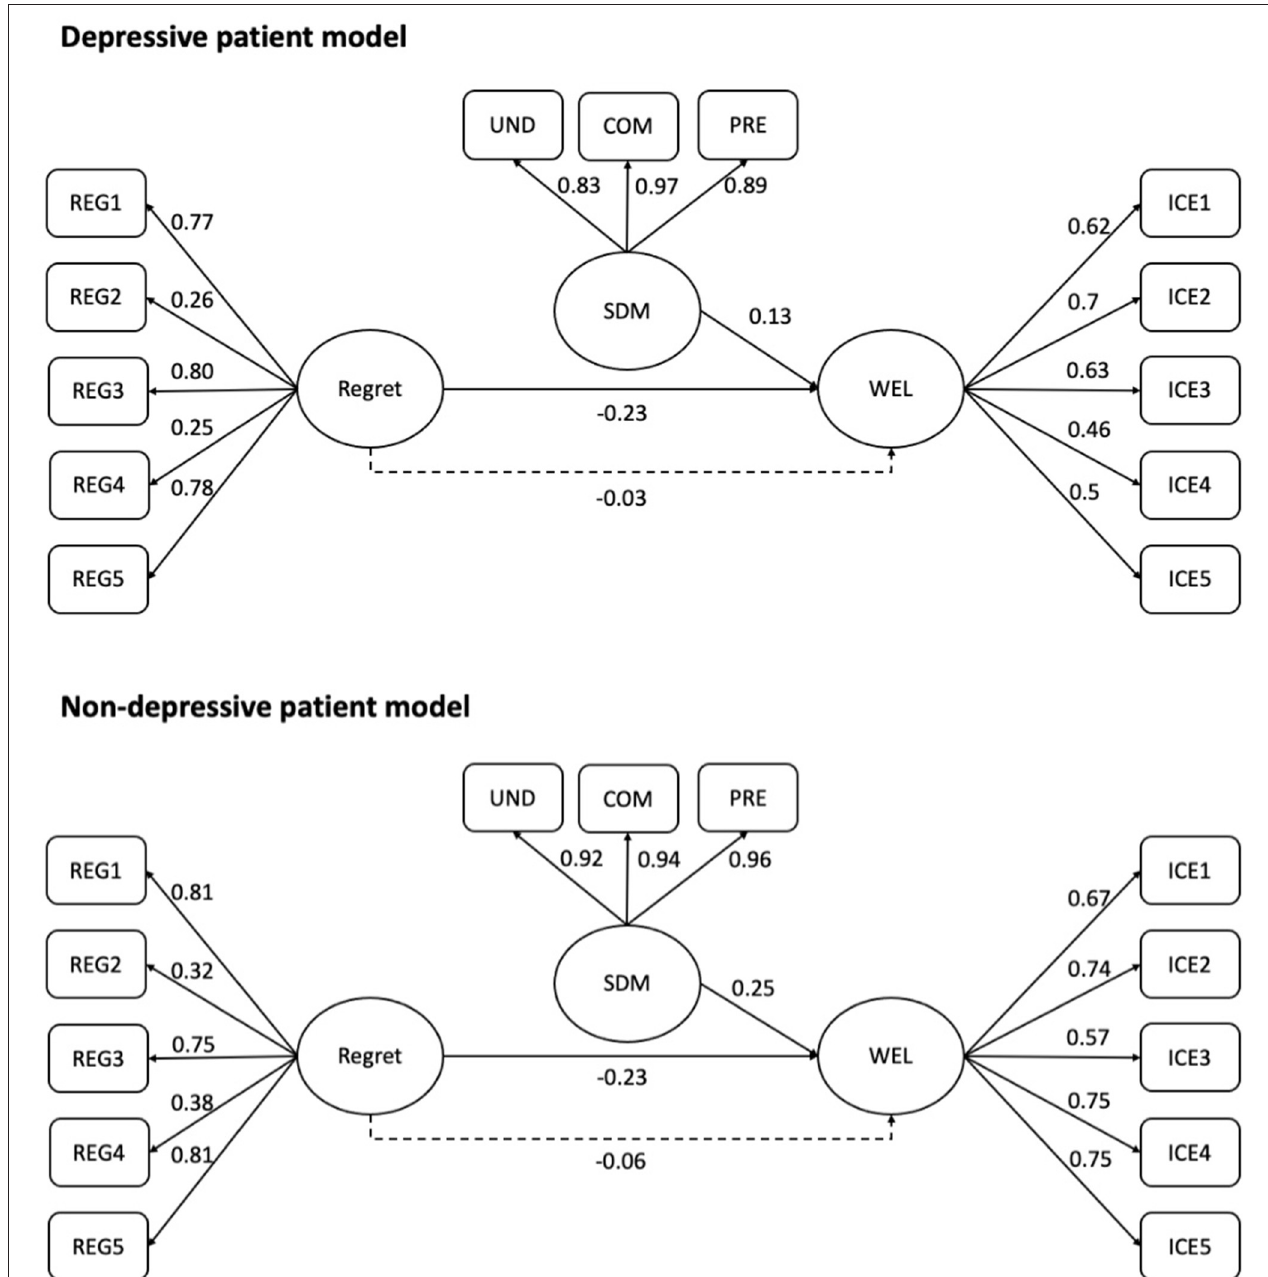
FIGURE 1 | The observed path models for patients with/without